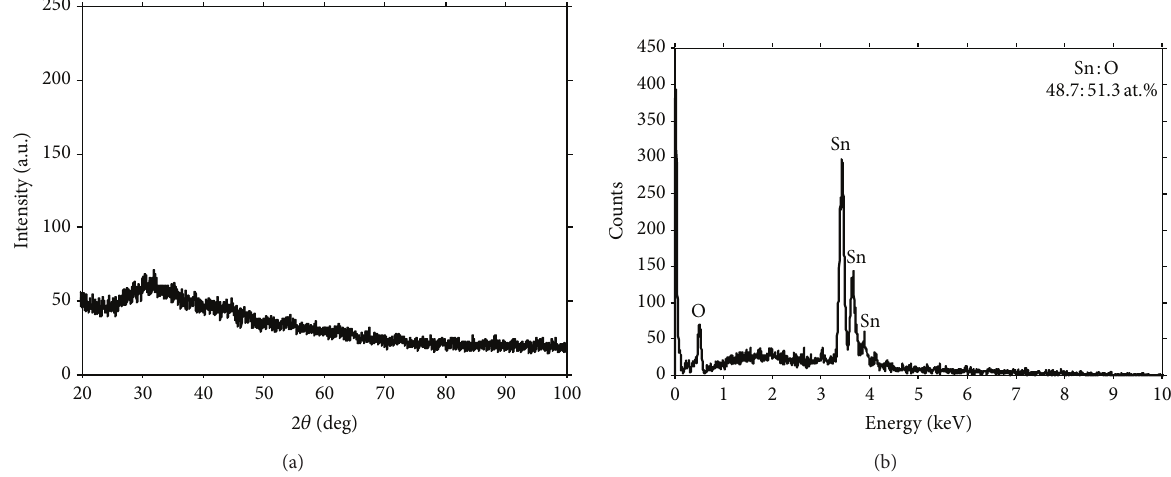
Figure 3: XRD pattern (a) and EDS spectrum (b) of the anodic tin oxide layer obtained during one-step anodization of low-purity Sn in B-type cell at a potential of 8